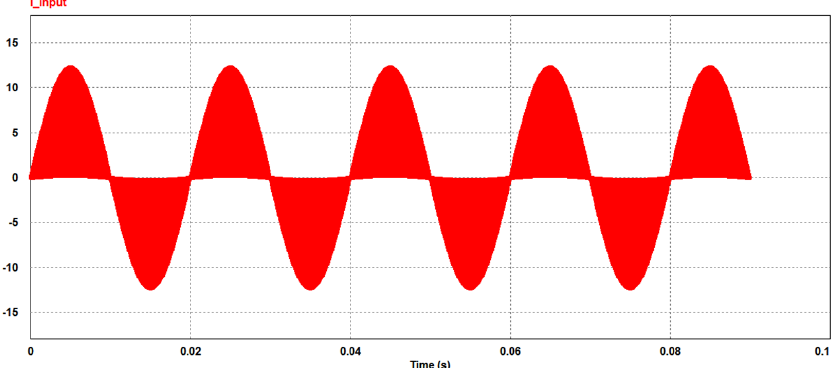
Figure 9. Input current waveform of an IH system without any filter.